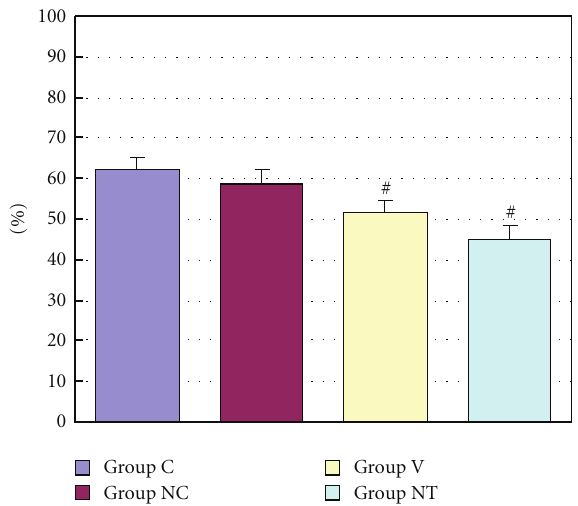
Figure 3: The figure shows I/R value (%), which means the infarct size expressed as percentage of area at risk. Group C: a control group. Group NC: a nicardipine group. Group V: a verapamil group. Group NT: a nitroglycerin group. # Significantly di ff erent ( P < . 05) from Group C (mean ±